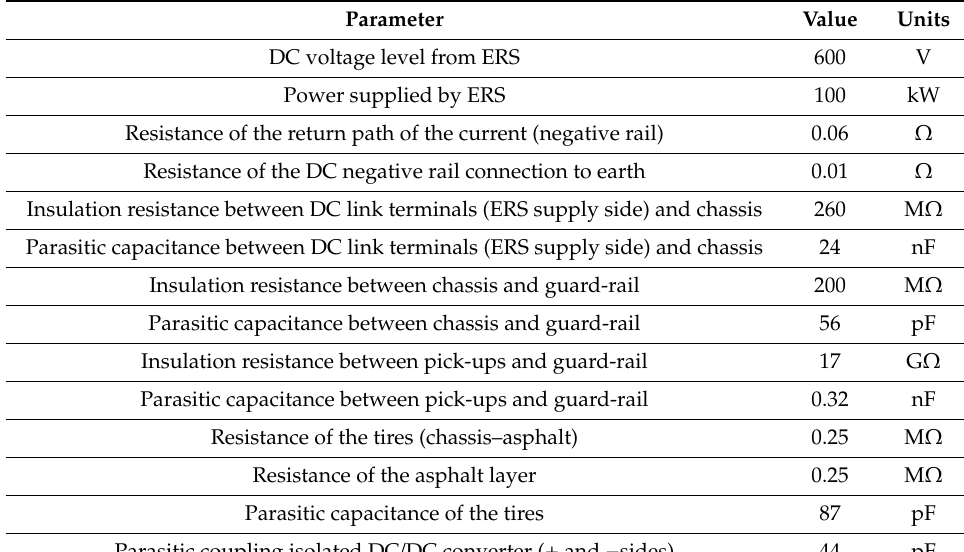
Table 1. Model parameters. ERS: electric road systems.